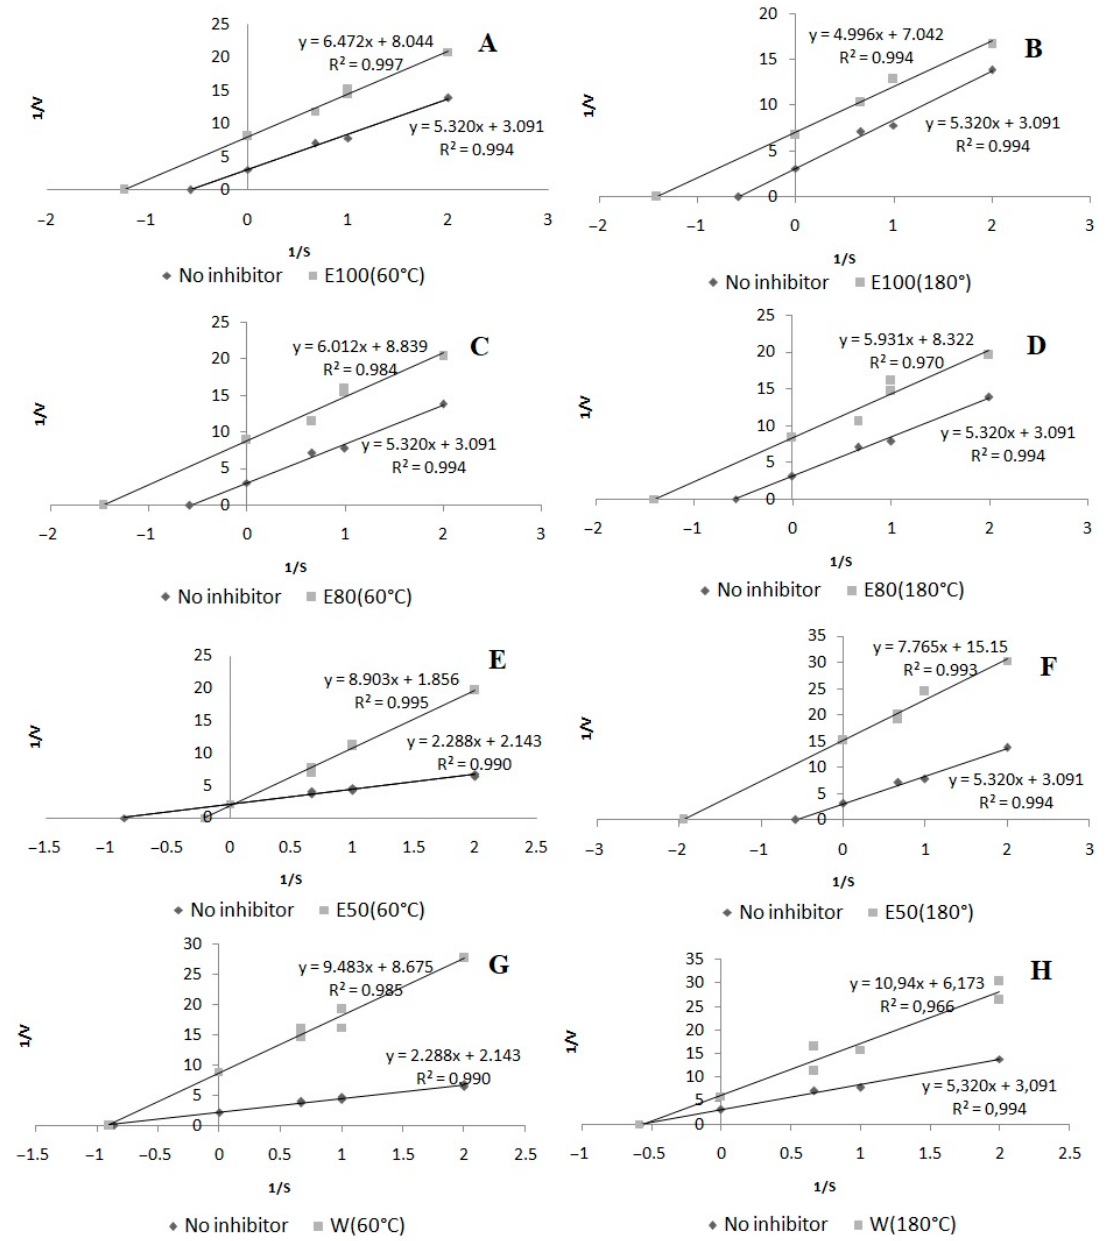
Figure 6. Mode of lipoxygenase inhibition by extracts from Aerva lanata (L.) Juss.: ( A ) 100% ethanol/60 ◦ C; ( B ) 100% ethanol/180 ◦ C; ( C ) 80% ethanol/60 ◦ C; ( D ) 80% ethanol/180 ◦ C; ( E ) 50% ethanol/60 ◦ C; ( F ) 50% ethanol/180 ◦ C; ( G ) water/60 ◦ C; ( H ) water/180 ◦